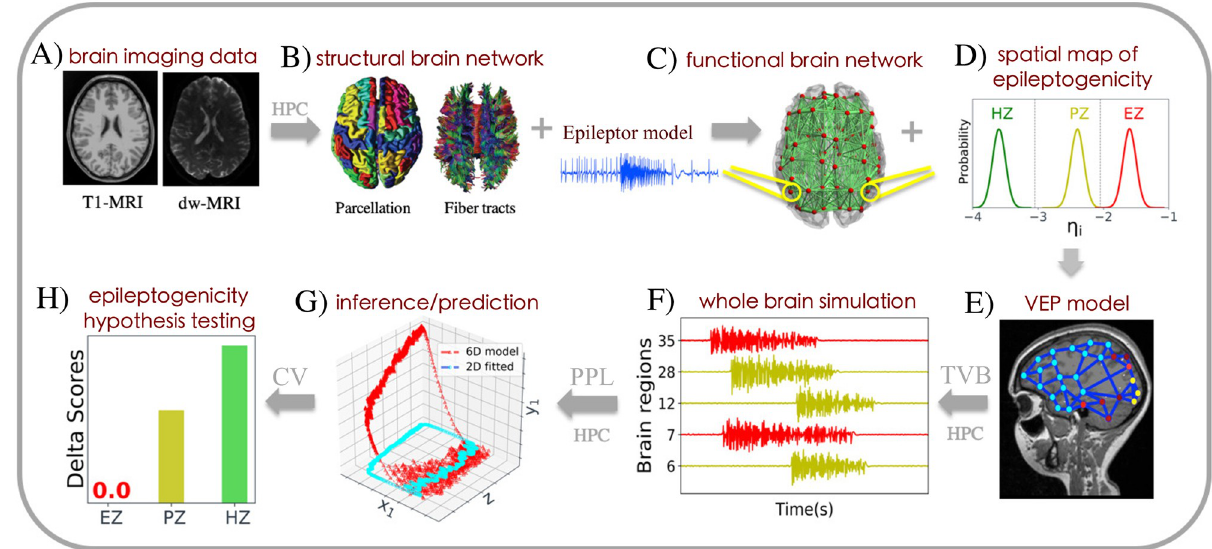
Fig 1. The workflow of BVEP aims at assessing different hypotheses regarding the location of an epileptogenic zone in a personalized whole- brain model of epilepsy spread. ( A ) At the first step, the patient undergoes non-invasive brain imaging such as MRI, and diffusion-weighted MRI (dwMRI). ( B ) Based on these images, the structural brain network model including brain parcellation and fiber tracts of the human brain are generated. ( C ) Then, a neural mass model (here 6D Epileptor) is defined at each brain region and connected through the structural connectivity matrix to build the functional brain network model. ( D , E ) Next, the VEP brain model is constructed by furnishing the functional brain network model with the spatial map of epileptogenicity (EZ, PZ, HZ hypotheses) across different brain regions. ( F ) The simulations by TVB allow to specifically mimic the individual’s spatiotemporal macro-level brain activity. ( G ) Subsequently, the generative VEP brain model is embedded within a PPL tool to invert the BVEP brain model (here 2D Epileptor) and evaluating the model against the patient’s data. ( H ) Finally, cross-validation (CV) is performed using WAIC/LOO to assess the model’s prediction performance on new data, in order to evaluate and validate the quality of the hypotheses regarding epileptogenicity.